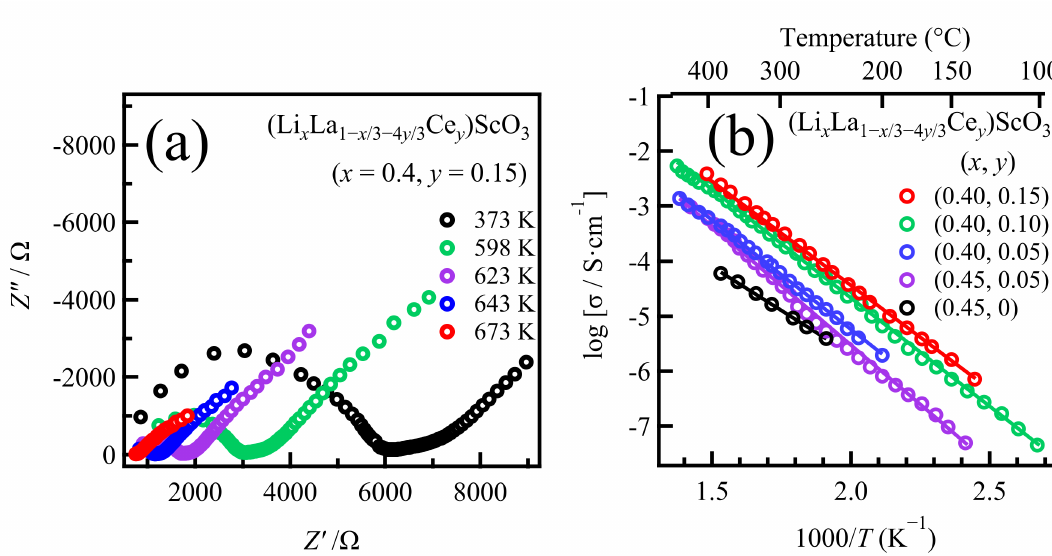
Figure 5. ( a ) Impedance plots of the representative co-doped (Li x La 1 − x /3 )ScO 3 at various temperatures, and ( b ) temperature dependence of the conductivity of the representative samples in (Li x La 1 − x /3 − 4 y /3 Ce y )ScO 3